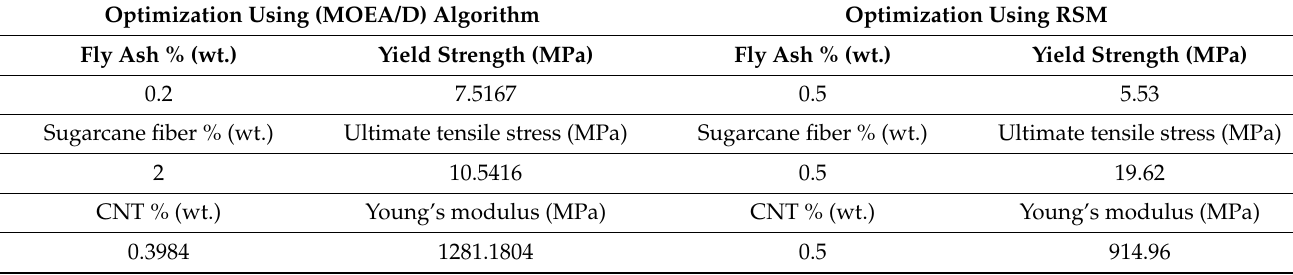
Table 8. Comparison of results obtained with experiments, RSM and multi-objective evolutionary algorithm (with ≥ 0.5 constraints) for maximum responses. Optimization Using (MOEA/D) Algorithm Optimization Using